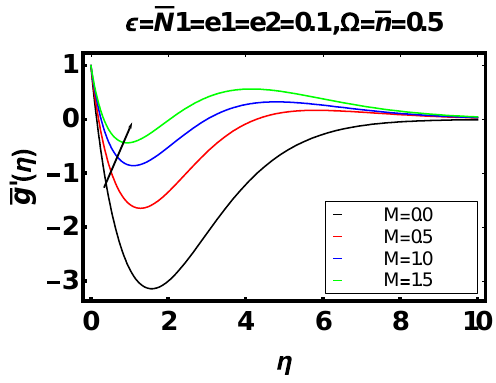
Figure 9. Velocity along x -direction for variant M . Table 3. Values for C f Re x , when e 2 = 0.1, γ = 0.1, δ = 0.2, α 1 , α 2 = 0.1, M = 0.1, Ω = 0.5, P r = 0.7, S c = 0.2.